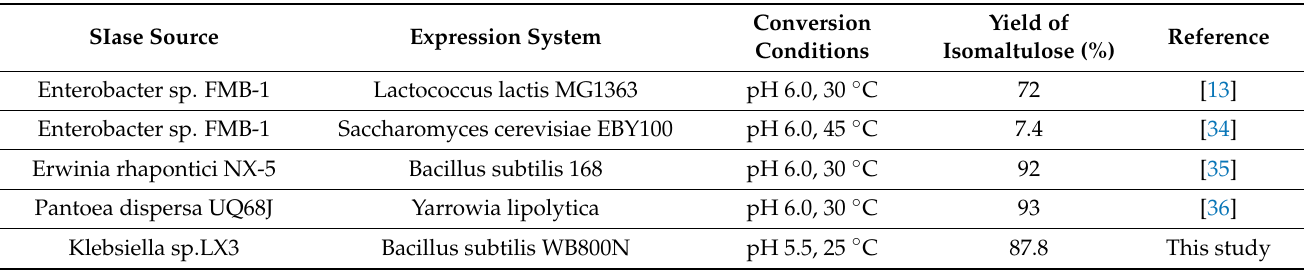
Figure 7. Time course of isomaltulose production catalyzed by KsLX3 ‐ SIase. Data are means ± SD from triplicate samples. Table 2. Conversion of sucrose to isomaltulose using SIases from various microbes with different expression systems.